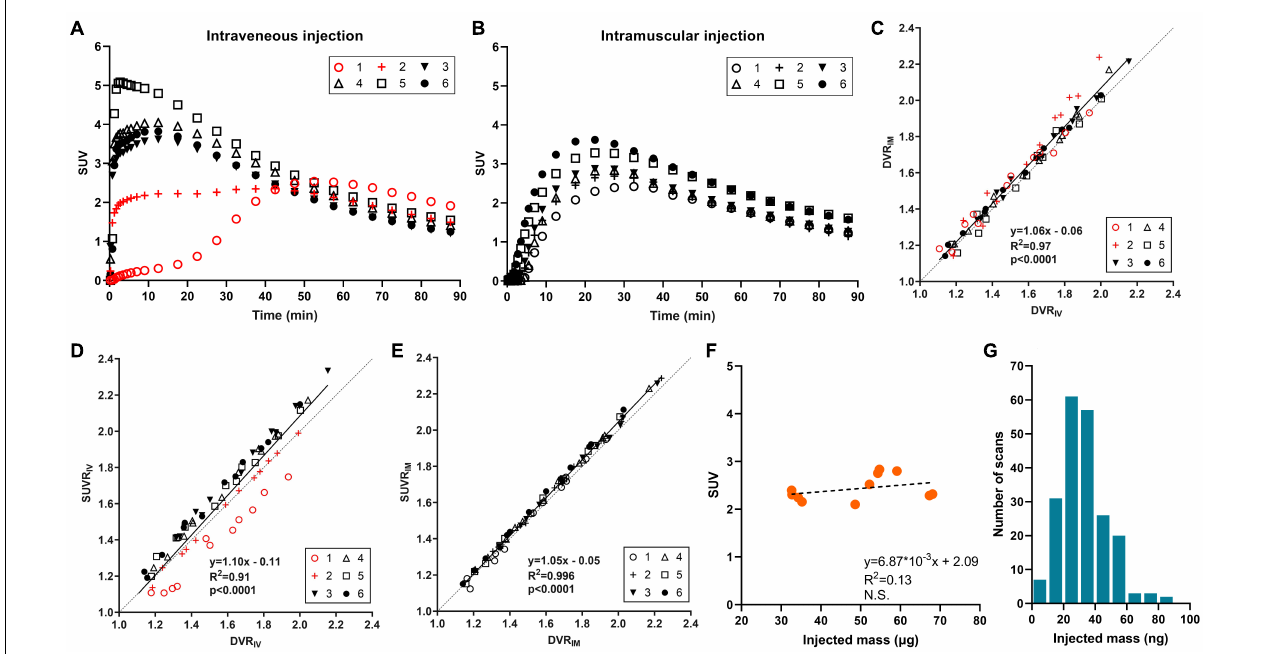
FIGURE 2 | [ 18 F]SynVesT-1 results in mice. (A) Time activity curves (TACs) with intravenous injection (2 animals with mixed intravenous/subcutaneous injection), and (B) TACs with intramuscular injection in six wild-type mice. (C) Correlation between distribution volume ratio (DVR) by intravenous injection (DVR IV ) and DVR by intramuscular injection (DVR IM ) for 12 brain regions. DVR was estimated with simplified reference tissue model (SRTM) using brain stem as a reference region. (D) Correlation between DVR IV and standardized uptake value ratio by intravenous injection (SUVR IV ) using 30–60 min post-injection data, also with brain stem normalization. (E) Correlation between DVR IM and SUVR by intramuscular injection (SUVR IM ). (F) Scatter plot of injected mass dose and whole brain SUV in wild-type mice ( n = 11), and (G) histogram of SynVesT-1 injected mass dose in mice ( n =